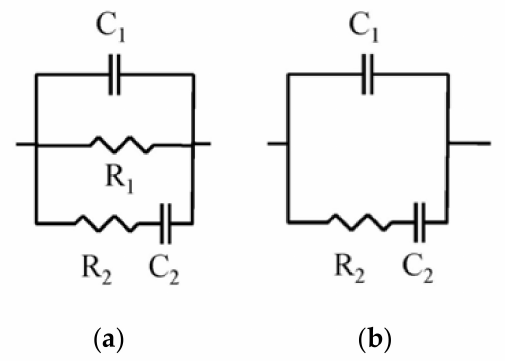
Figure 2. ( a ) Equivalent circuit for the contacting method [18,27]; ( b ) Equivalent circuit for the non-contacting method [18,27]. Reprinted with permission from [18,27] 2018